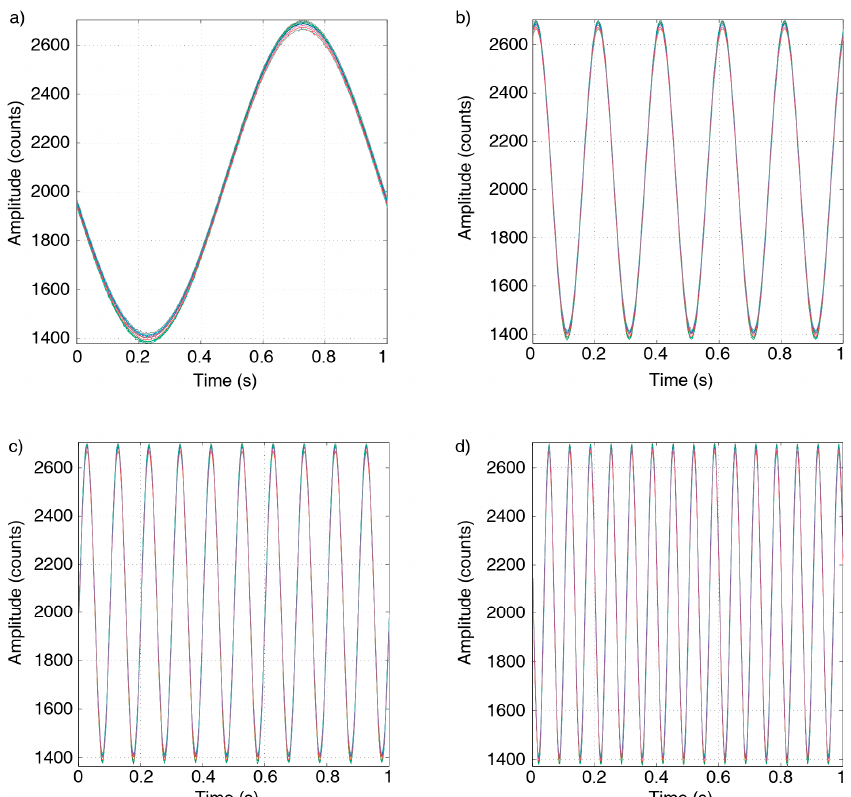
Figure 18. Synchronization test for sine waves in the range of 1–15 Hz, with 0.1 V amplitude. ( a ) 1 Hz; ( b ) 5 Hz; ( c ) 10 Hz; ( d ) 15 Hz. Twelve simultaneously registered signals are shown in each test.